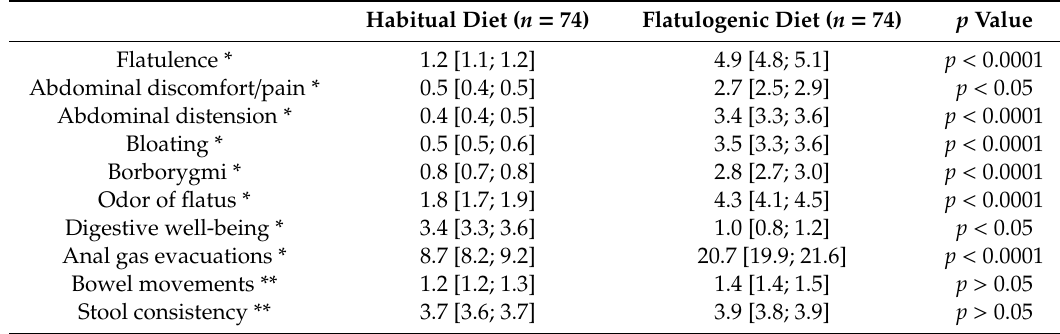
Table 1. E ff ects of the flatulogenic diet on gas-related symptoms and frequency of anal gas evacuations.